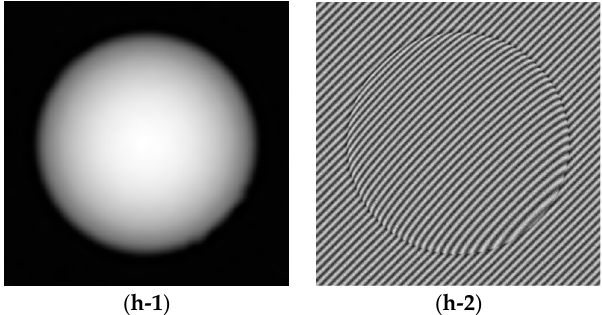
Figure 8. The decomposed background and fringe of Figure 1 by Shearlet transform method with different parameter values. ( a-1 ) decomposed background from Figure 1a with decomposition layer 3; ( b-1 ) decomposed background from Figure 1a with decomposition layer 4; ( c-1 ) decomposed background from Figure 1b with decomposition layer 3; ( d-1 ) decomposed background from Figure 1b with decomposition layer 4; ( e-1 ) decomposed background from Figure 1c with decomposition layer 3; ( f-1 ) decomposed background from Figure 1c with decomposition layer 4; ( g-1 ) decomposed background from Figure 1d with decomposition layer 3; ( h-1 ) decomposed background from Figure 1d with decomposition layer 4; ( a-2 ) decomposed fringe from Figure 1a with decomposition layer 3; ( b-2 ) decomposed fringe from Figure 1a with decomposition layer 4; ( c-2 ) decomposed fringe from Figure 1b with decomposition layer 3; ( d-2 ) decomposed fringe from Figure 1b with decomposition layer 4; ( e-2 ) decomposed fringe from Figure 1c with decomposition layer 3; ( f-2 ) decomposed fringe from Figure 1c with decomposition layer 4; ( g-2 ) decomposed fringe from Figure 1d with decomposition layer 3; ( h-2 ) decomposed fringe from Figure 1d with decomposition layer 4.